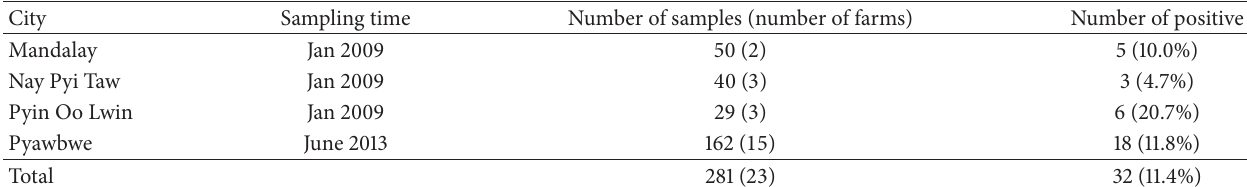
Table 1: Seroprevalence of T. gondii infection in goats in four cities in Myanmar.